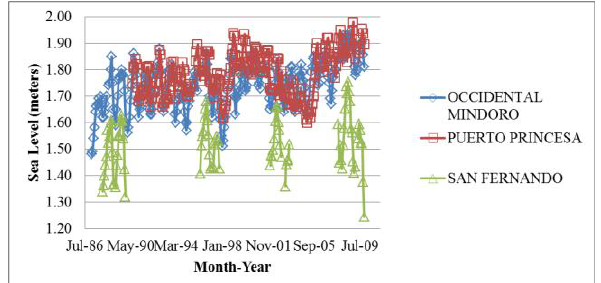
Figure 4. Monthly sea level records at the San Jose, Occidental Mindoro, Puerto Princesa, Palawan and San Fernando, La Union stations.